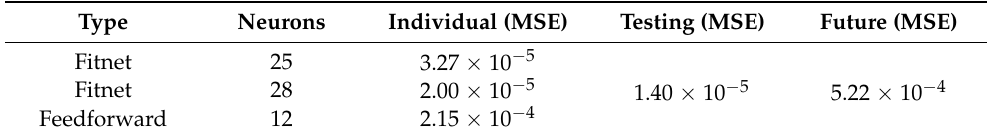
Table 6. Best architecture for